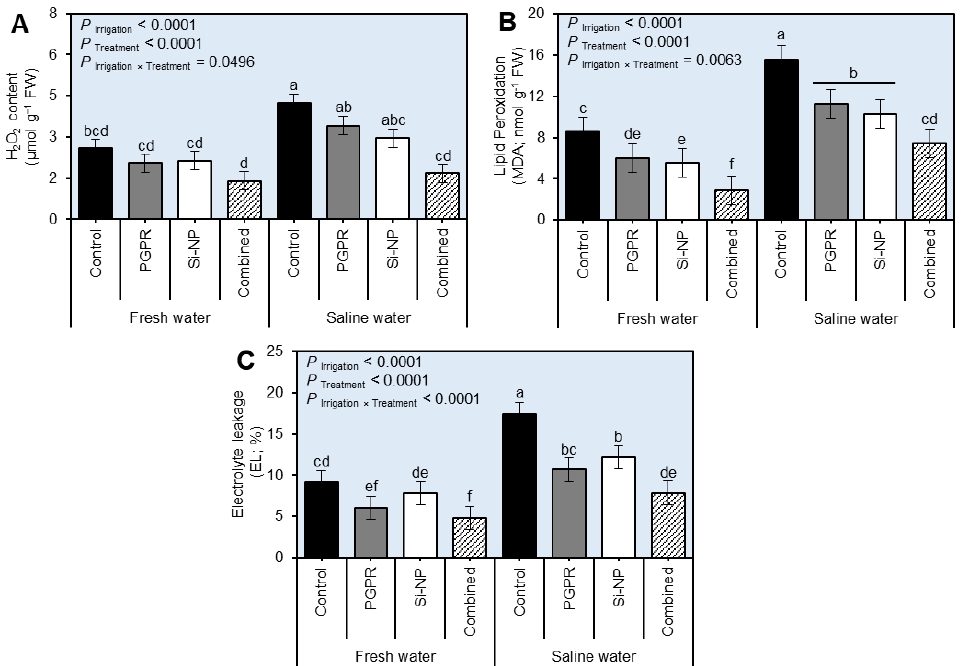
Figure 5. Effect of seed inoculation with PGPR and/or Si-NP foliar application on the water relations and chlorophyll reading of sugar beet plants grown in salt-affected soil and subjected to saline water irrigation during the 2019/2020 seasons. ( A ) H 2 O 2 content (µmol g −1 FW), ( B ) lipid peroxidation (MDA; nmol g −1 FW), and ( C ) electrolyte leakage (EL; %) during the 2019/2020 seasons, respectively. Data presented are the means ± standard deviation (mean ± SD) of three biological replicates. Dif- ferent letters signify statistically significant differences between treatments according to Tukey’s HSD test ( P Irrigation × Treatment ≤ 0.05).